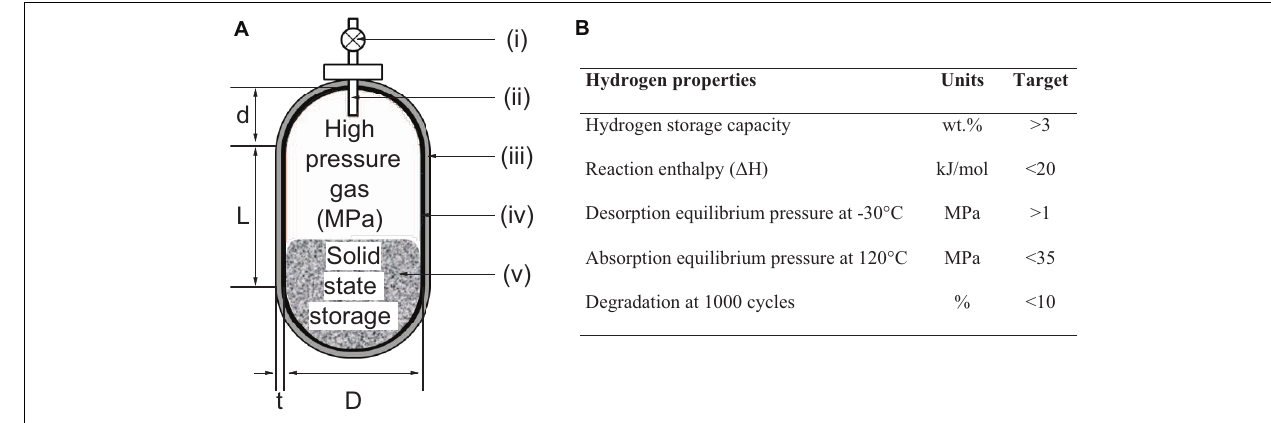
FIGURE 12 | Hybrid hydrogen storage vessel: (A) Schematic representation of novel hybrid hydrogen vessel were (i) valve, (ii) tube for hydrogen, (iii) carbon fiber and epoxy resin, (iv) thin aluminum liner and (v) hydrogen storage material such as TiFe and TiCr 57 . 5 V 5 (Takeichi et al., 2003); (B) Table showing estimated target values of hydrogen storage materials for hybrid high-pressure vessel (Mori et al., 2005; Shibuya et al.,